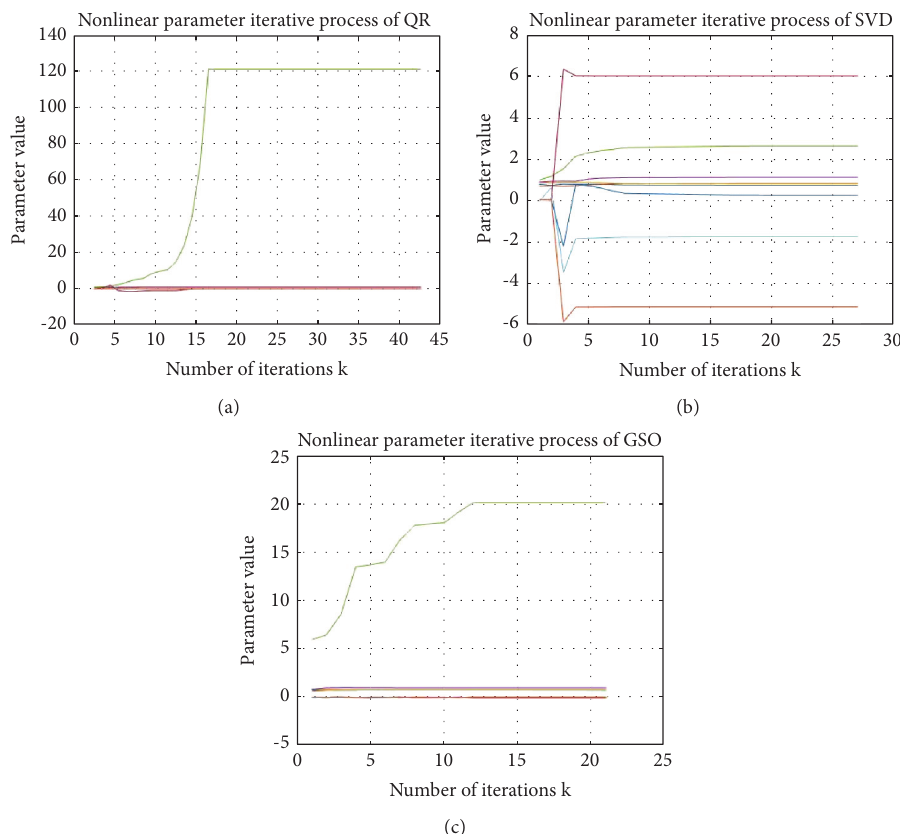
Figure 5: Iterative convergence curves: (a) VP